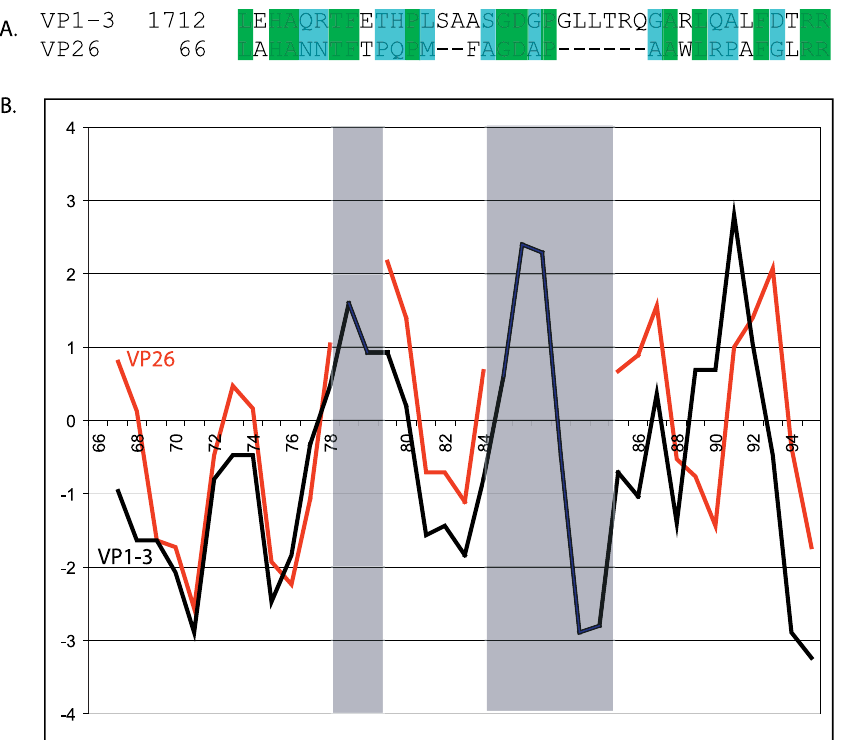
Figure 6. Common Sequence Motif in VP26 and VP1–3 A sequence alignment of VP26 and VP1–3 is shown in (A). Identical residues are shown in green, while conserved residues are shown in cyan blue. In (B), the hydropathy profiles of this region from VP26 (red) and VP1–3 (black) are plotted and labeled with respect to the VP26 sequence. The shaded panels indicate the regions of insertion found in the sequence alignment. DOI: